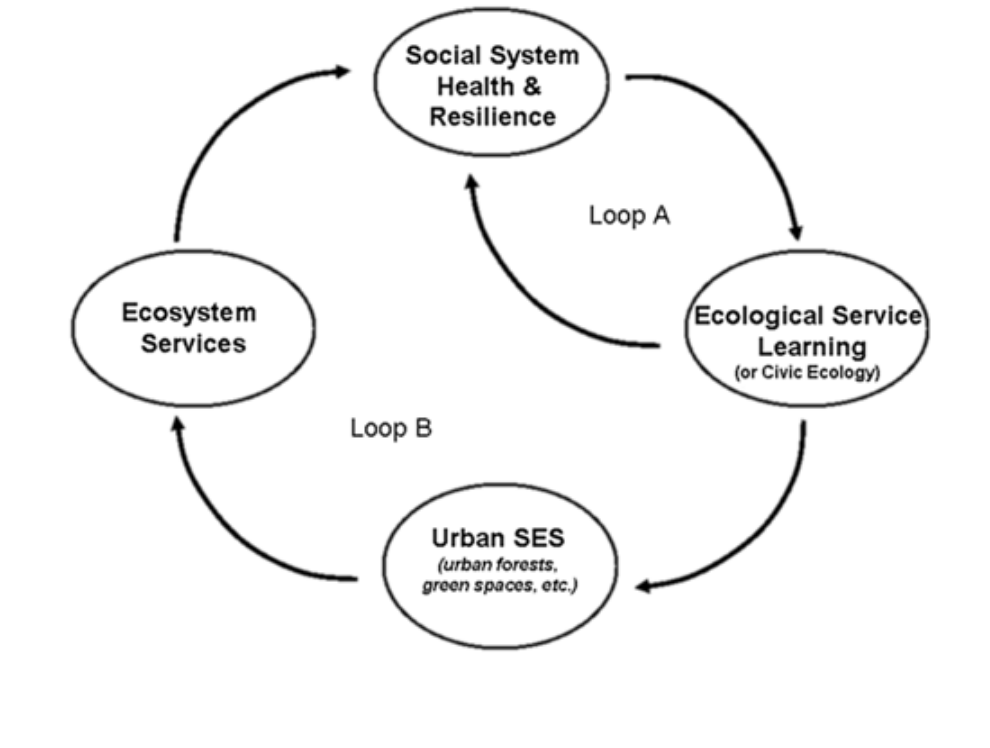
Fig. 3. Ecological service learning to foster resilience: feedback loops depicting the relationships among ecological service learning and social and ecosystem resilience. Starting on the right with the smaller feedback loop (A), ecological or environmental service learning fosters social system health and resilience; more service learning leads to more social system health and resilience, which in turn leads to more ecological service learning and so on. The larger feedback loop (B) shows how ecological service learning or civic ecology practice (e.g., community tree planting) enhances the urban forest, which in turn maintains ecosystem services. These ecosystem services contribute to and enhance social system health and resilience, which may spawn additional civic ecology practice and ecological service learning. (Diagram draws from work of Kuo et al. 1998, Miles et al. 1998, Kuo and Sullivan 2001, Wells and Evans 2003, Wells and Lekies 2006, and Resilience Alliance